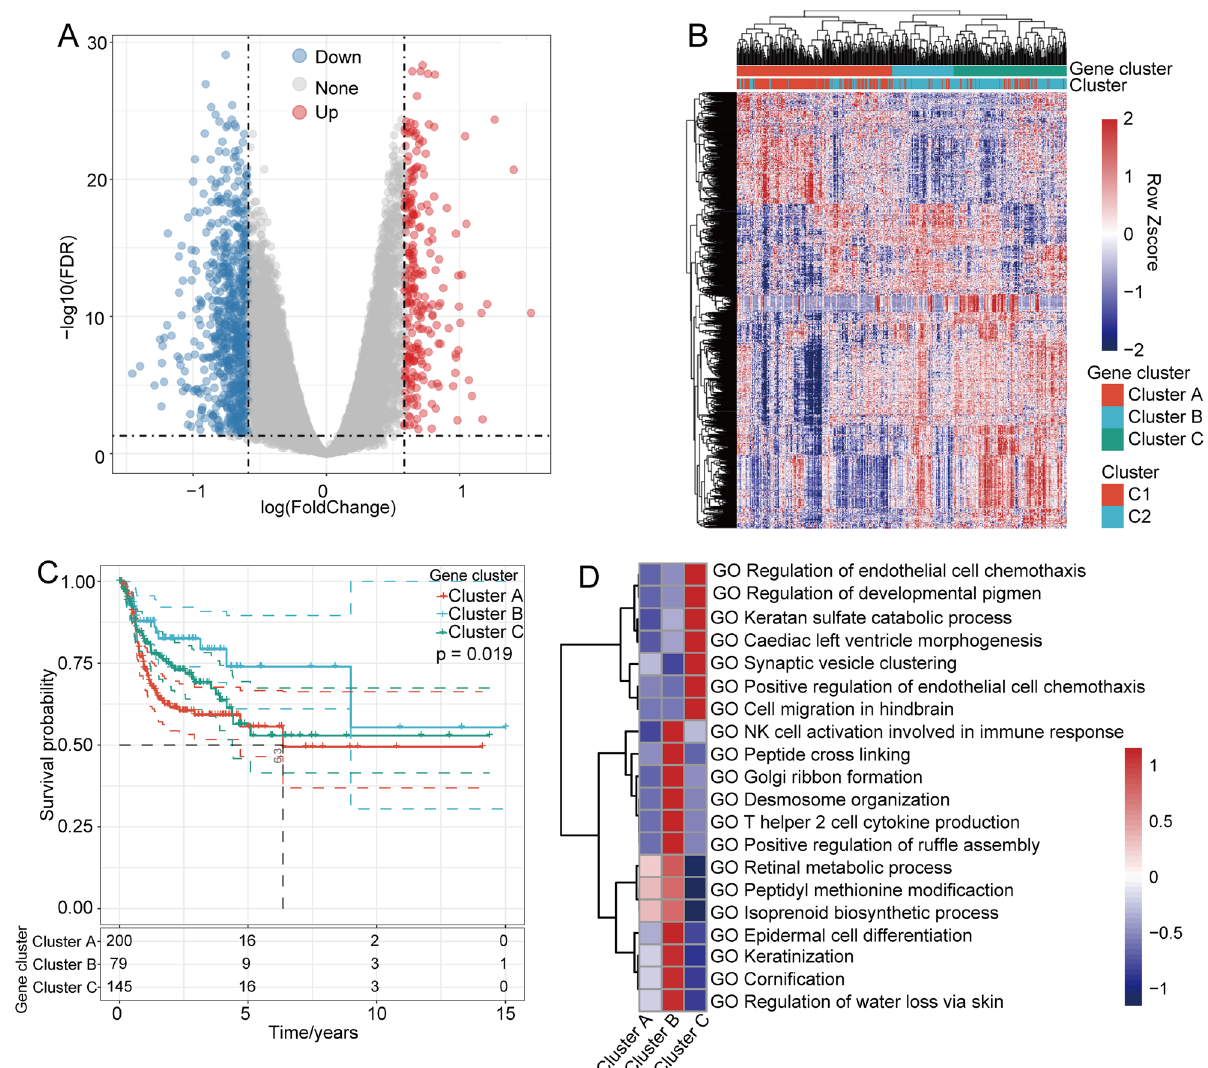
clusters, A, B, and C, were enriched in different